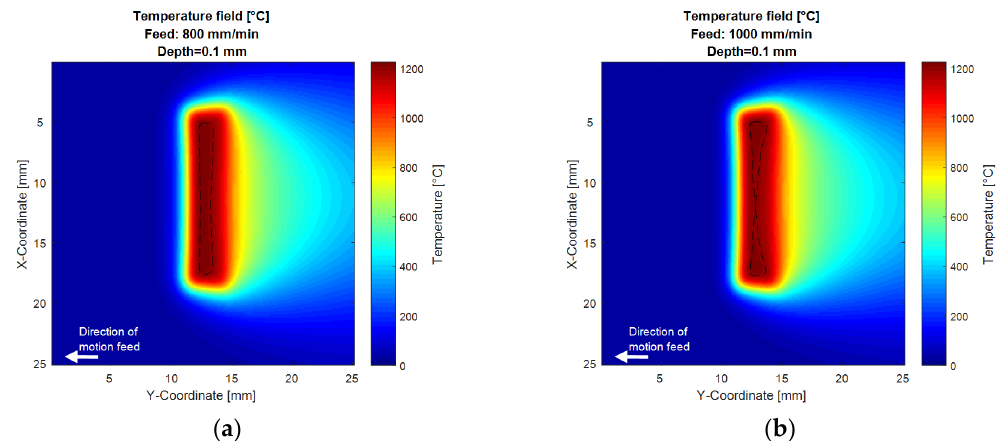
Figure 12. Simulated temperature field at a depth of 0.1 mm in 42CrMo4 (AISI 4140) for the optimized profile at the feed of 800 ( a ) and 1000 mm/min ( b ).